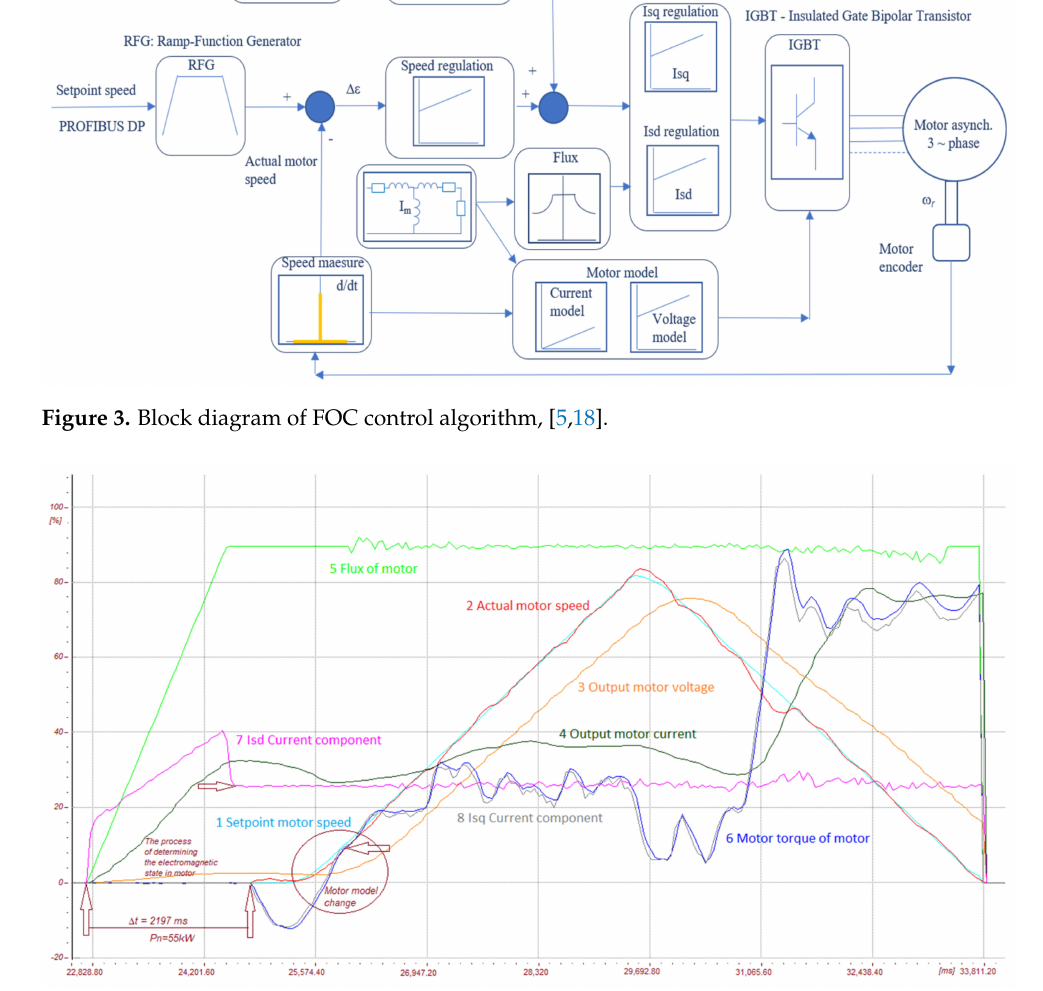
Figure 4. Starting process of the inverter drive system in the feeder